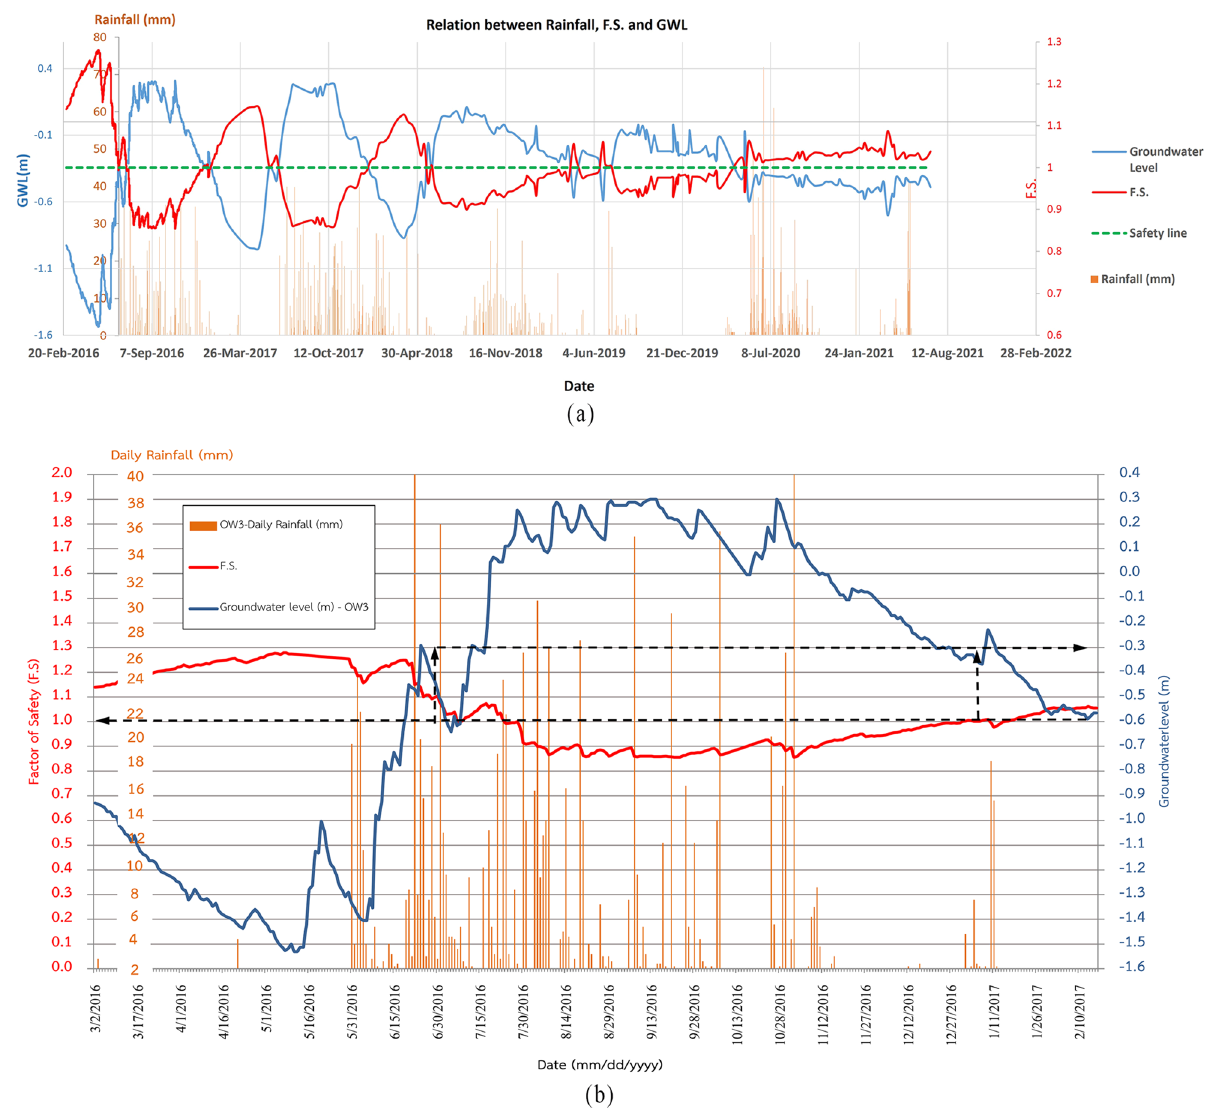
Figure. 8. ( a ) Relation between rainfall intensity, FS and groundwater table for a period of 4 years ( b ) Zoomed-in section for